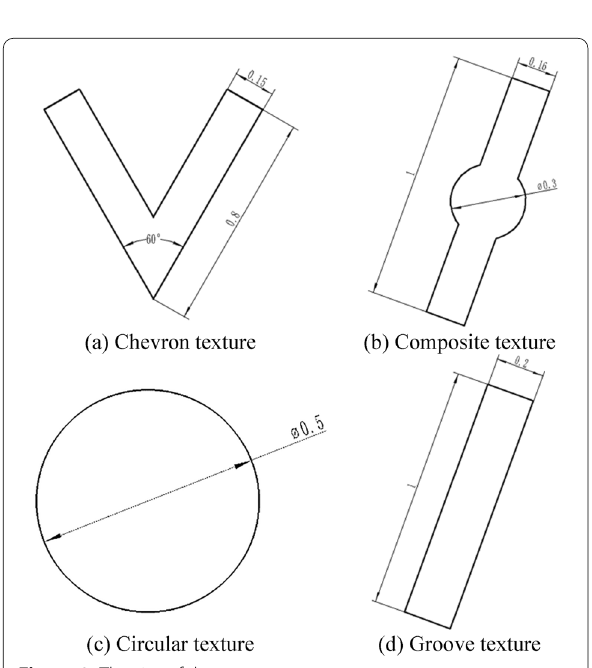
Figure 3 The size of the